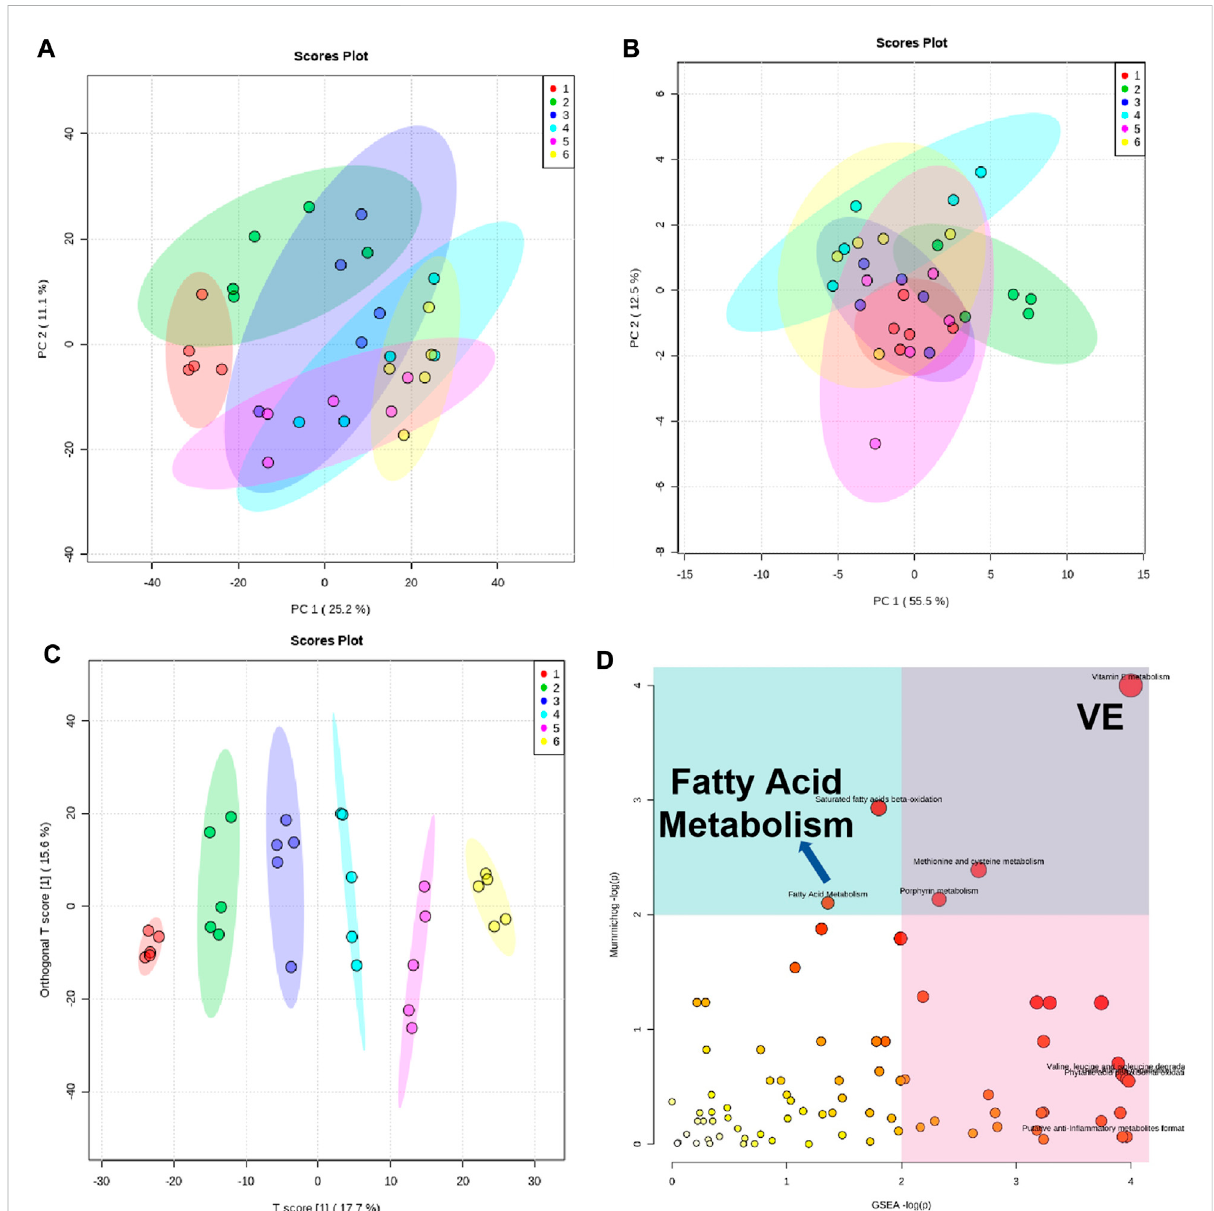
Analysis of metabolic content in the rat serum of groups 1 – 6. (A) PCA of the biological pathway according to the metabolic differences. Each pointrepresentedacomponent. (B – C) :PCAofthedistributionofthe25functionalcomponents wescreened. (D) Analysisofthebiologicalpathway according to the metabolic differences. Pathways associated with PPAR γ (VE-related metabolism and fatty acid metabolism) are